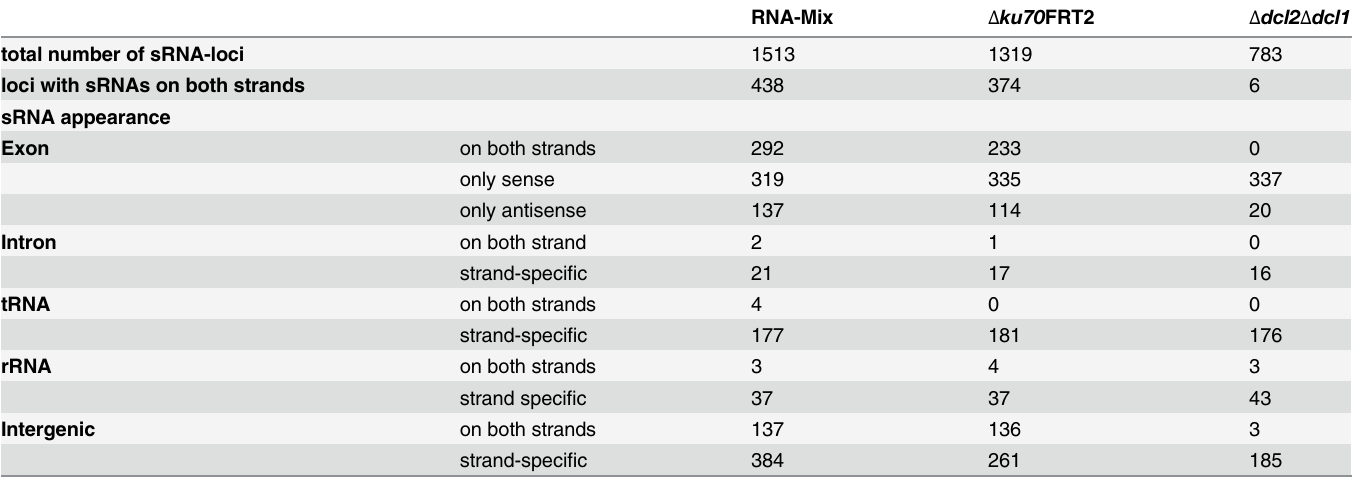
Table 2. Characterization of small RNA producing